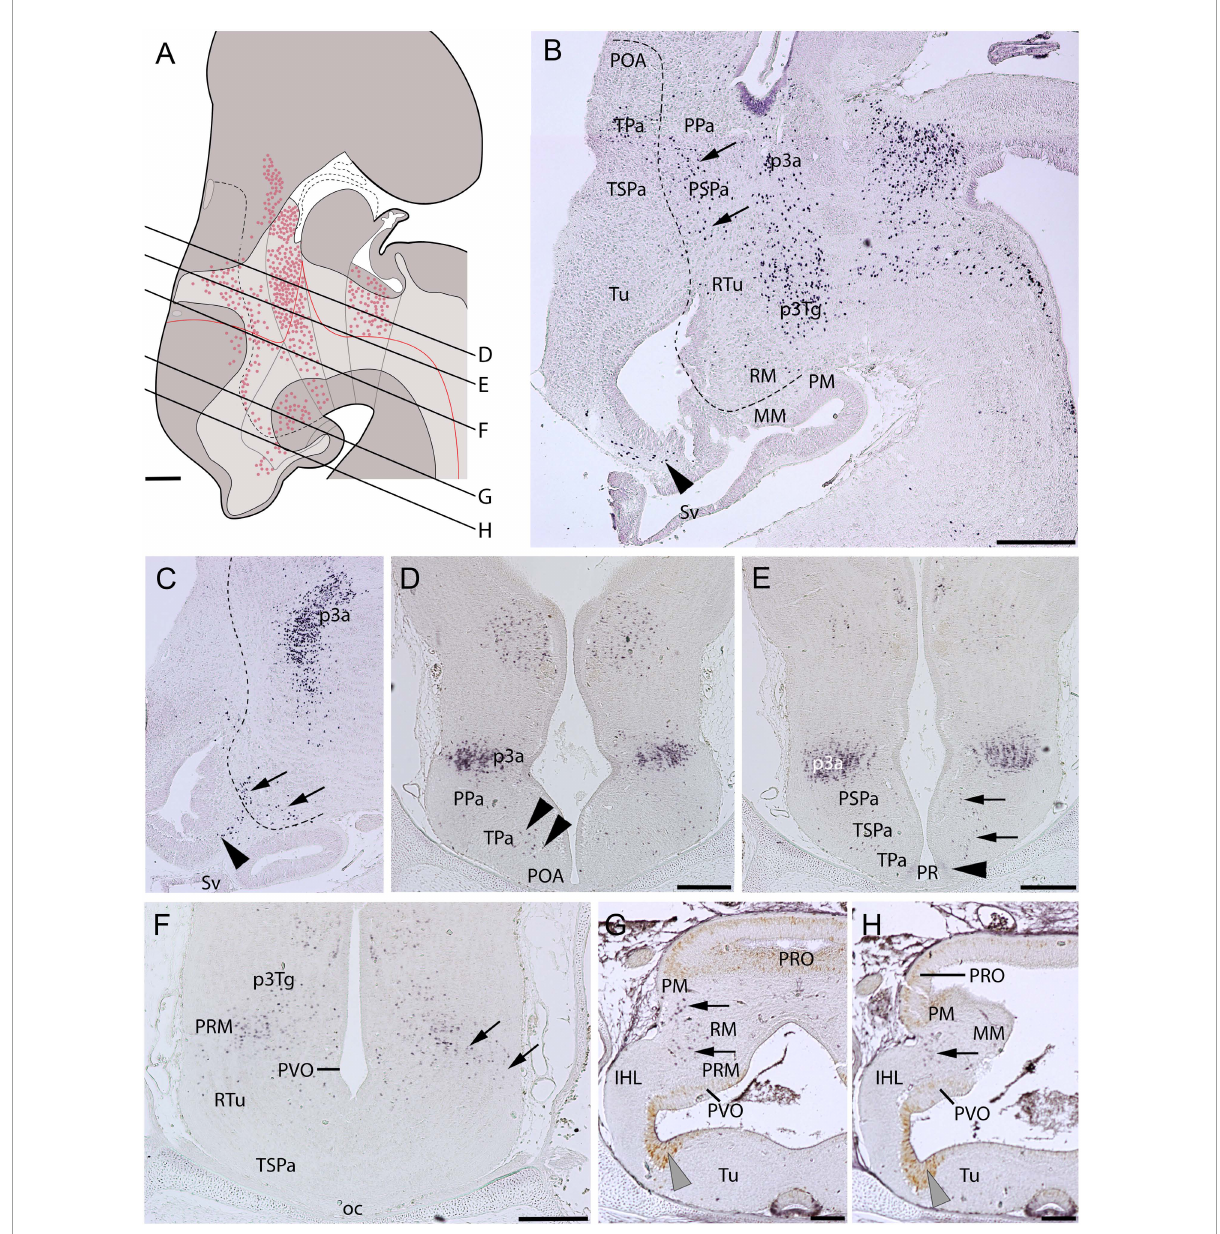
FIGURE4 Regionalization of the hypothalamus of Scyliorhinus canicula at stage 32 based on immunohistochemistry against Pax6 (red color in A ; B–F ) and PCNA ( G,H ) in sagittal ( B,C ) or transverse ( D–H ) sections. Scheme on (A) represent a maximal projection of the expression found in sagittal and parasagittal sections. Lines represent the level of transverse sections. Ventricular labeling is represented with solid color while mantle cells are represented with dots. Dashed lines in (B,C) represent the IHB. Arrows in (B,C) point to Pax6-ir cells following the IHB. Black arrowheads in (C) point to Pax6-ir cells in the Tu. Black arrowheads in (D) show Pax6-ir cells at the POA (subpallium)/TPa border. Black arrowhead in (E) point to Pax6-immunoreactivity in the PR. Gray arrowheads in (G,H) point to PCNA-immunoreactivity in the inferior hypothalamic lobes. For abbreviations, see list. Scale bars: 125 µ